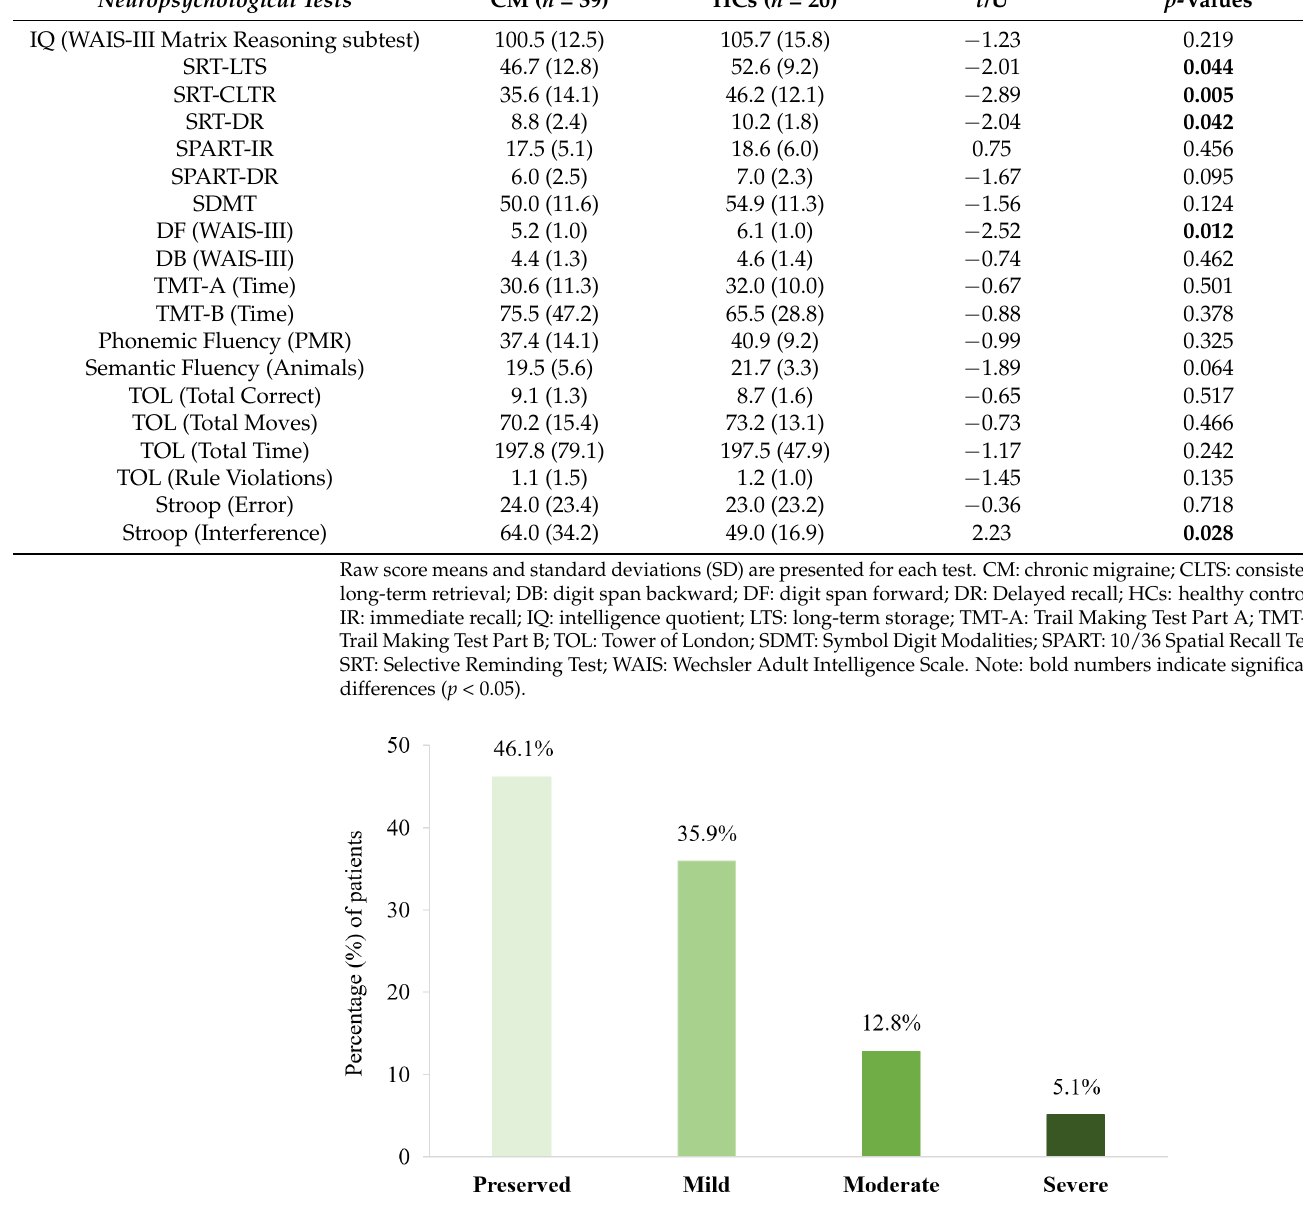
Figure 1. Percentages of CM patients displaying different degrees of neuropsychological impair- ment. Preserved: failed 3 or fewer neuropsychological tests; Mild: failed 4 – 7 neuropsychological